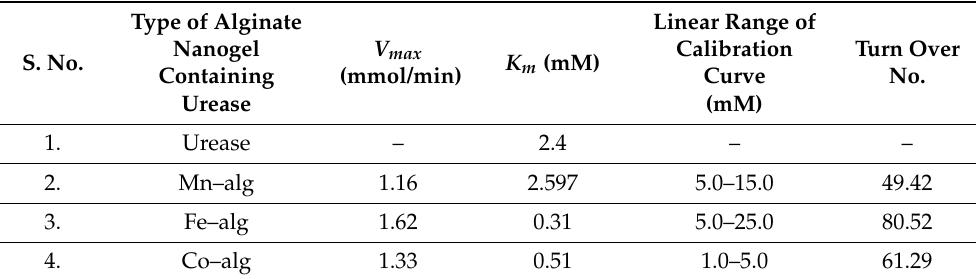
Table 5. Kinetic parameters of immobilized urease enzyme in different alginate nanogels cross-linked with Mn 2+ , Fe 3+ , and Co 2+